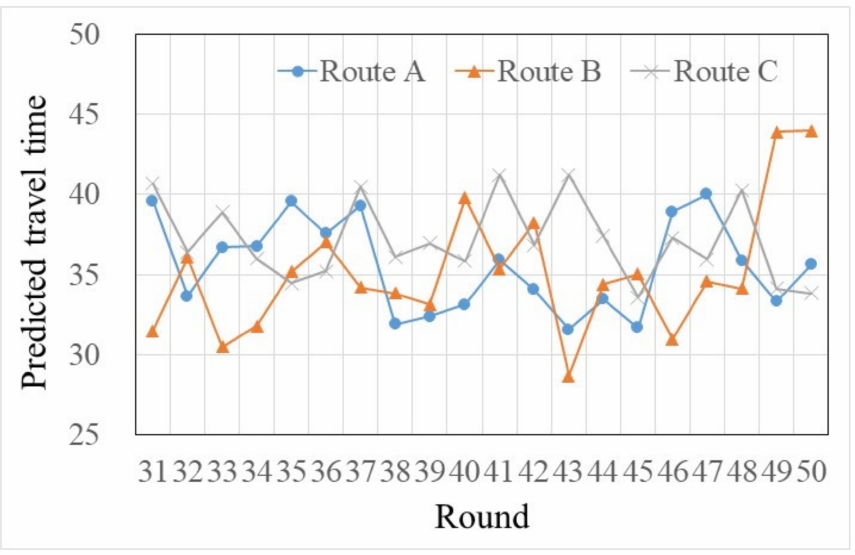
Figure 8. The travel time predicted by pre-trip traffic information in rounds